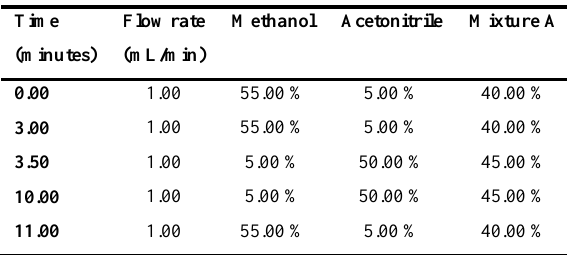
Table 2. The developed gradient elution